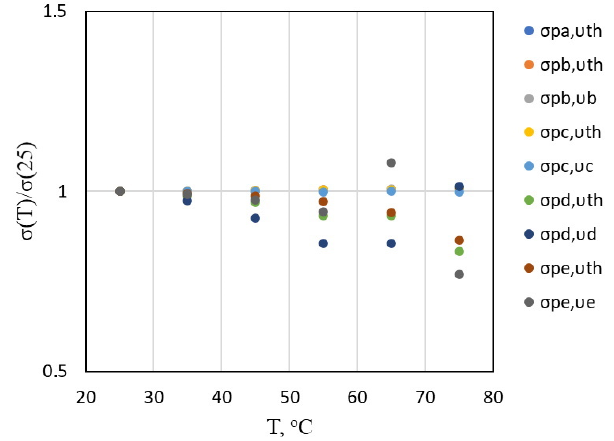
Figure 16. Dependency of cavitation number from temperature in characteristic points. Venturi tube nozzle (from our CFD results).